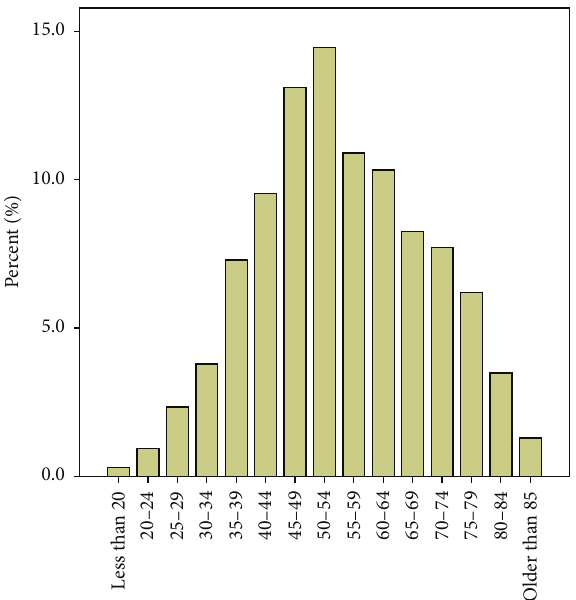
Figure 3: Age distribution of patients who had RAI treatment.